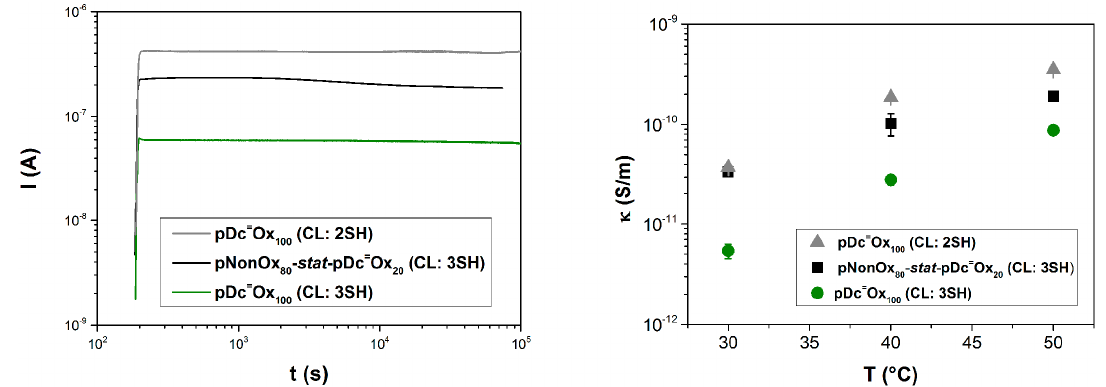
Figure 4. Measurements of the electrical conductivity of the poly(2-oxazoline)-based networks. (Left) : Time-dependent set-up of constant current conditions; ( Right ): Electrical conductivities for the polymer networks at 30, 40, and 50 °C.